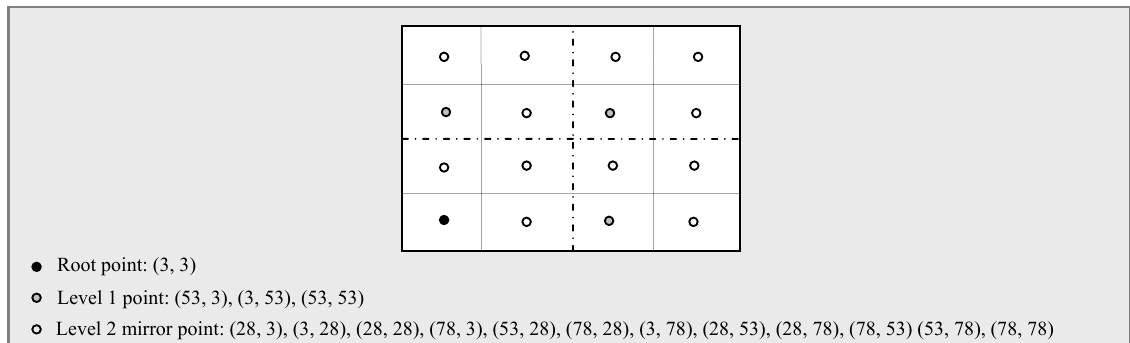
Figure 6. Structured Replication